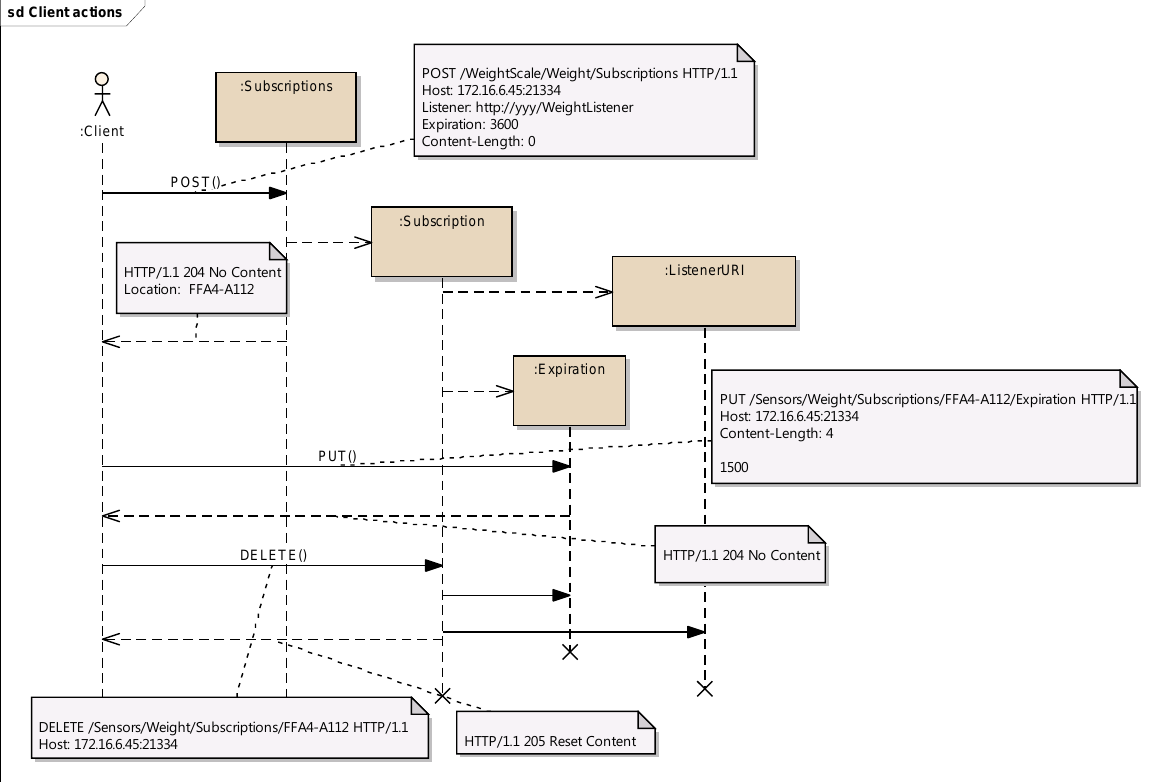
Figure 8. Interactions between resources of event source.